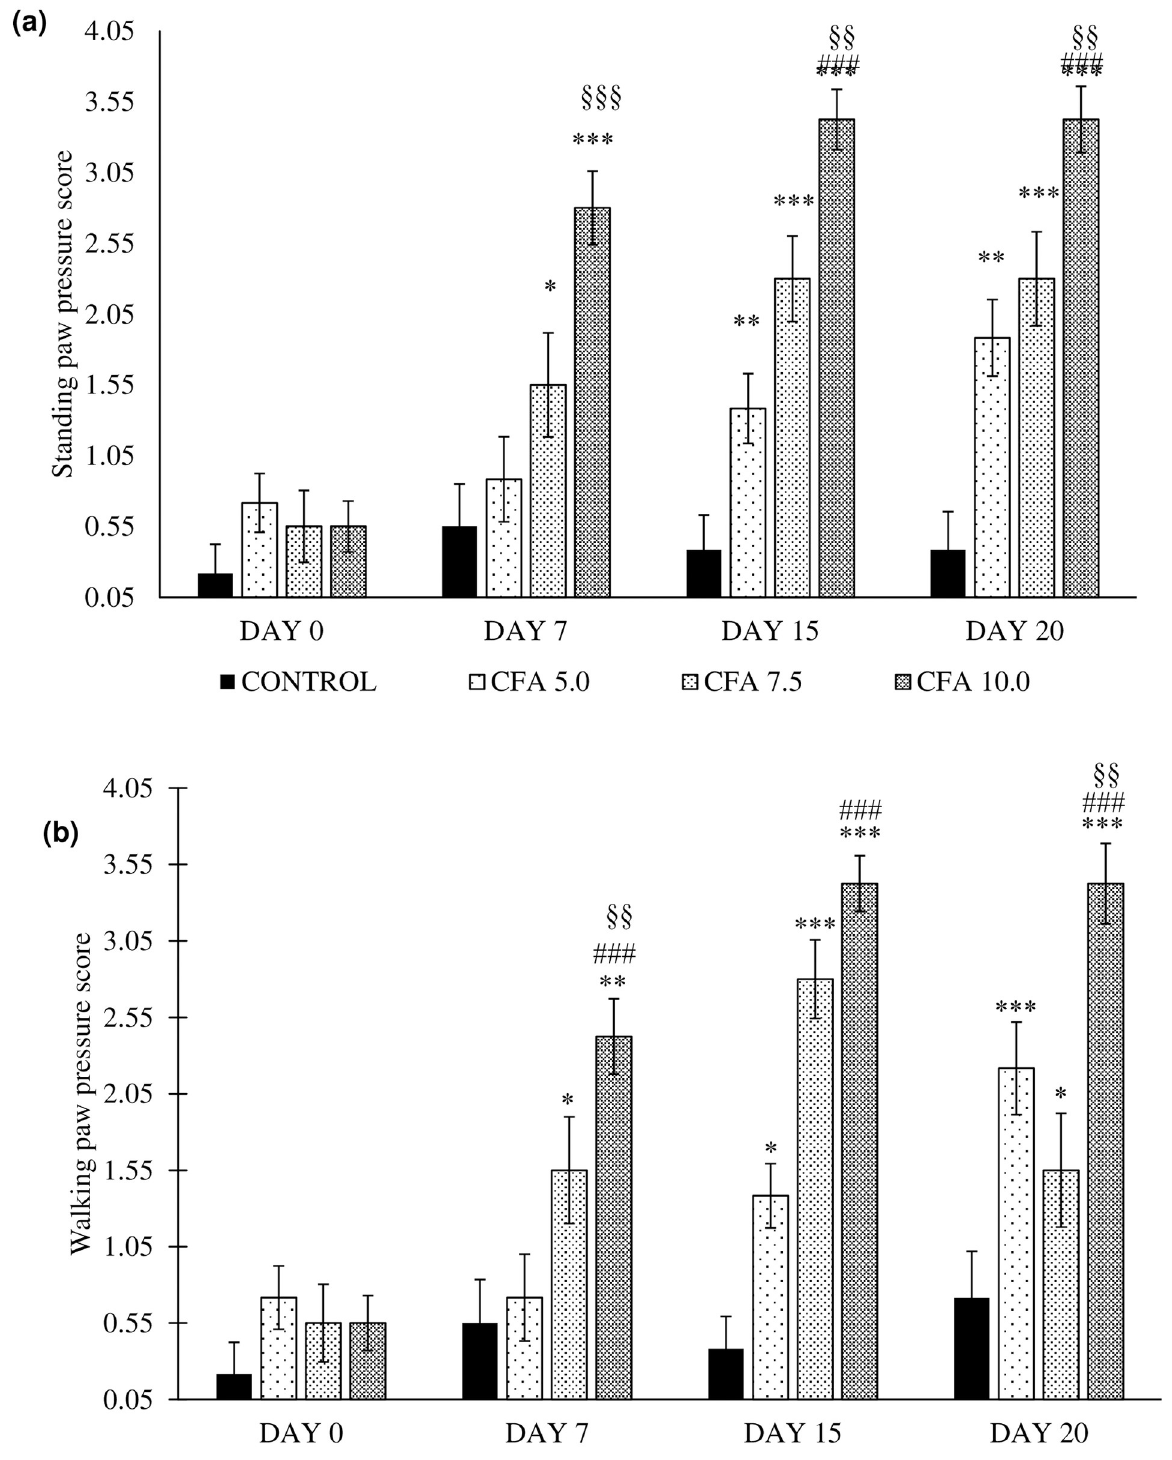
Fig 3. Spontaneous activities as indicated by (a) standing paw pressure and (b) walking paw pressure in the groups on day 0, 7, 15 and 20 (n = 6). The data are presented as mean ± standard error of the mean (SEM). � p < 0.05, �� p < 0.01, ��� p < 0.001 Statistical comparison to control group, ### p < 0.001 Significant comparison to CFA 5.0 group and §§ p < 0.05, §§§ p < 0.001 Significant comparison to CFA 7.5 group. The CFA 10 group showed the most consistent and the highest score for both standing and walking paw pressure compared to the control group, especially on day 7, 15 and